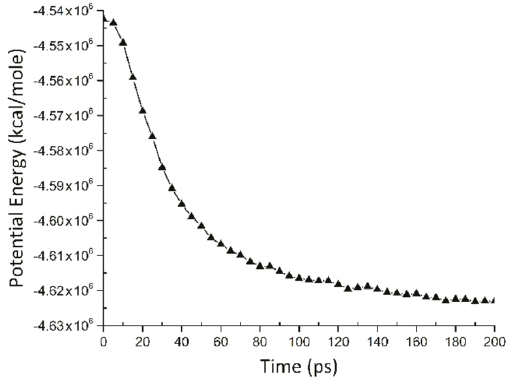
Figure 6. Decrease of potential energy as a function of time for single sphere model.